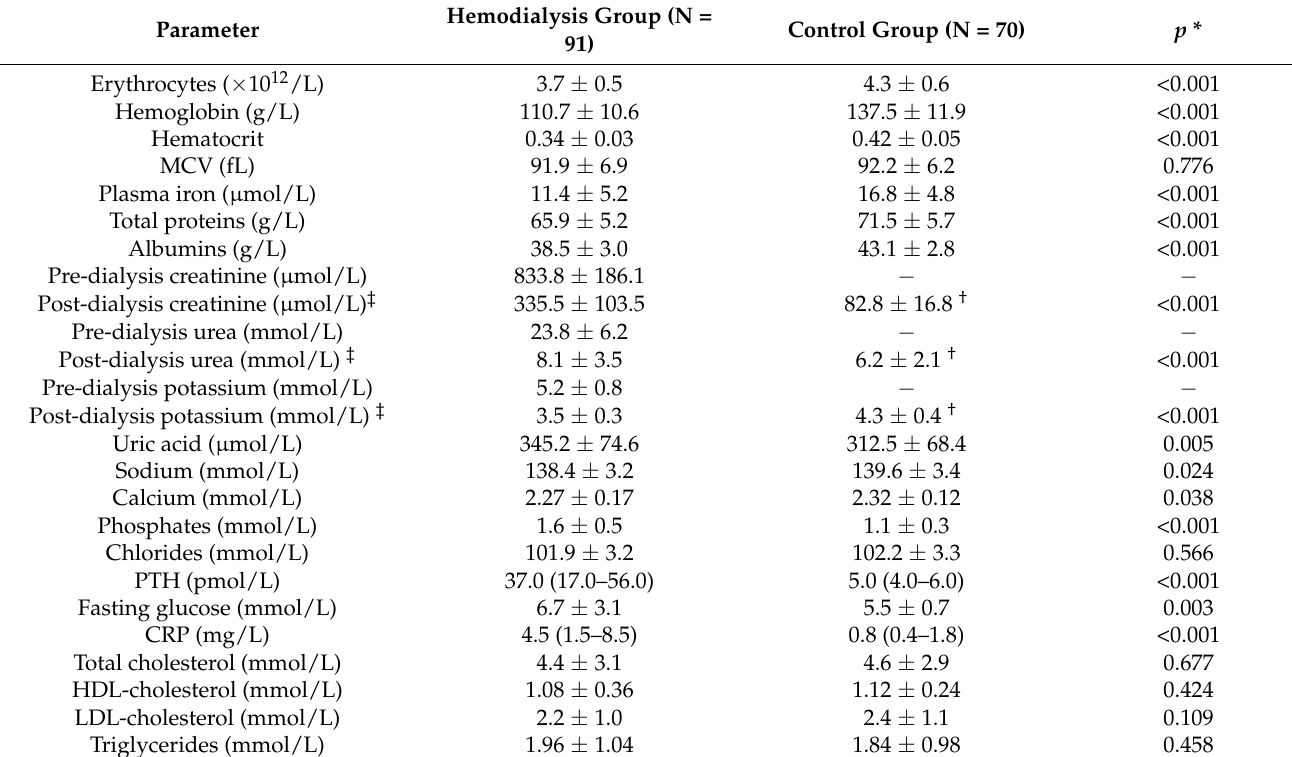
Table 2. Laboratory findings of hemodialysis patients.